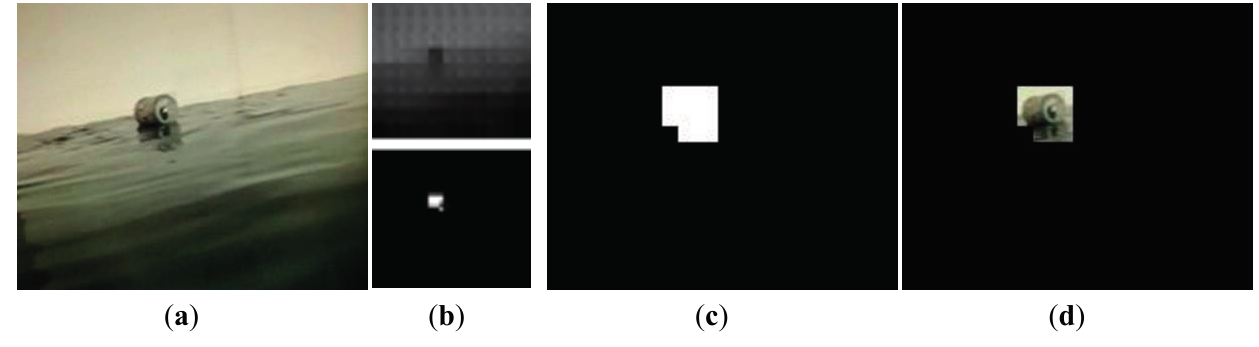
Figure 7. Foreground extraction with 16 × 16 block. ( a ) Original frame; ( b ) The reconstruction frame and its foreground mask; ( c ) The real foreground mask with scale = 4 and bicubic interpolation; and ( d ) Foreground object in original